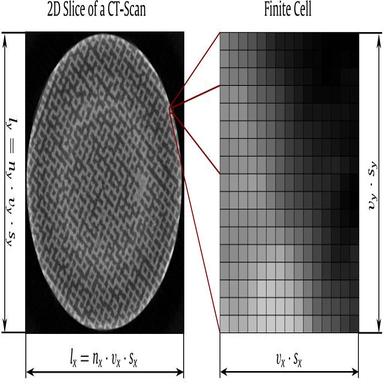
2D Slice of a CT-scan with an example of a finite cell.